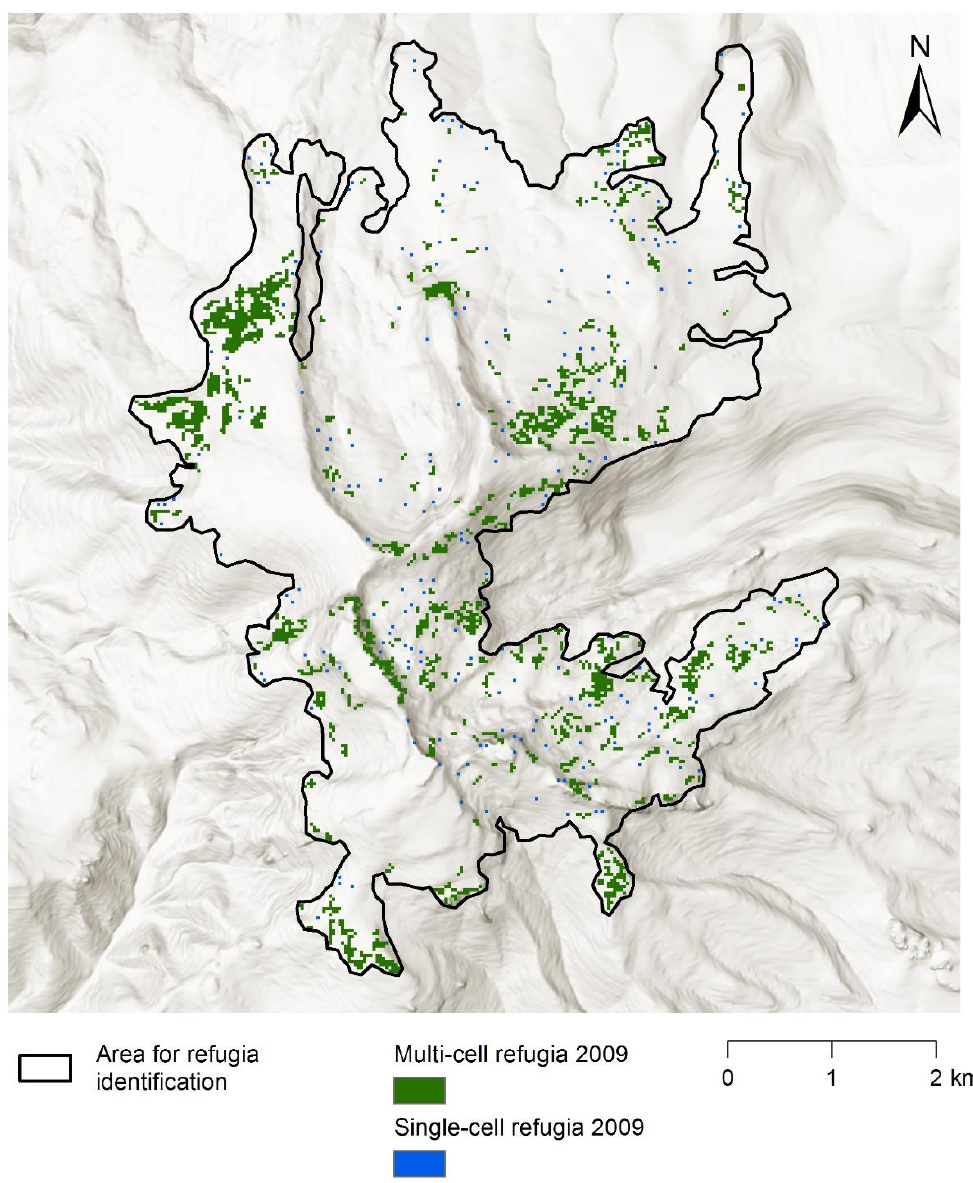
Figure A2. Refugia identified in 2009 (10% of grid cells, stratified by forest type, that had the highest NDMI anomalies in 2009) and multi-cell refugia identified in 2009 (clusters of two or more contiguous grid cells identified as refugia in 2009).